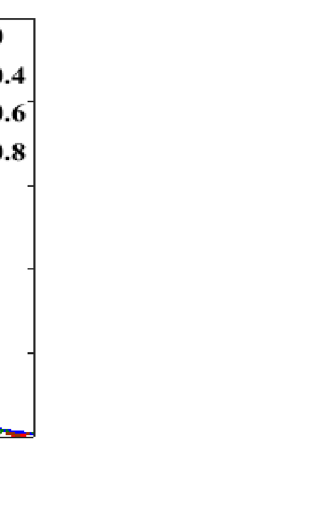
Figure 12. G / G 0 versus (cid:31) for different values of k B T at (cid:31) = 0.6, eV m = 0.5, γ = 0.02